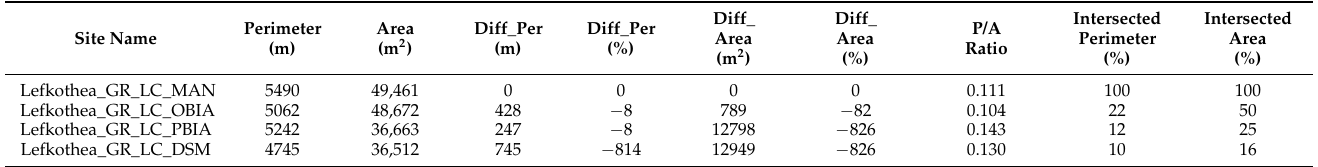
Figure 10. Outlining the extent of landslide boundaries using the four classifications: ( a ) overall extent of four classifications; ( b ) eroded land next to the road; ( c ) and ( d ) gullied and eroded translational zones; ( e ) deposition zone of landslide debris in the Lefkothea case study site in Greece.